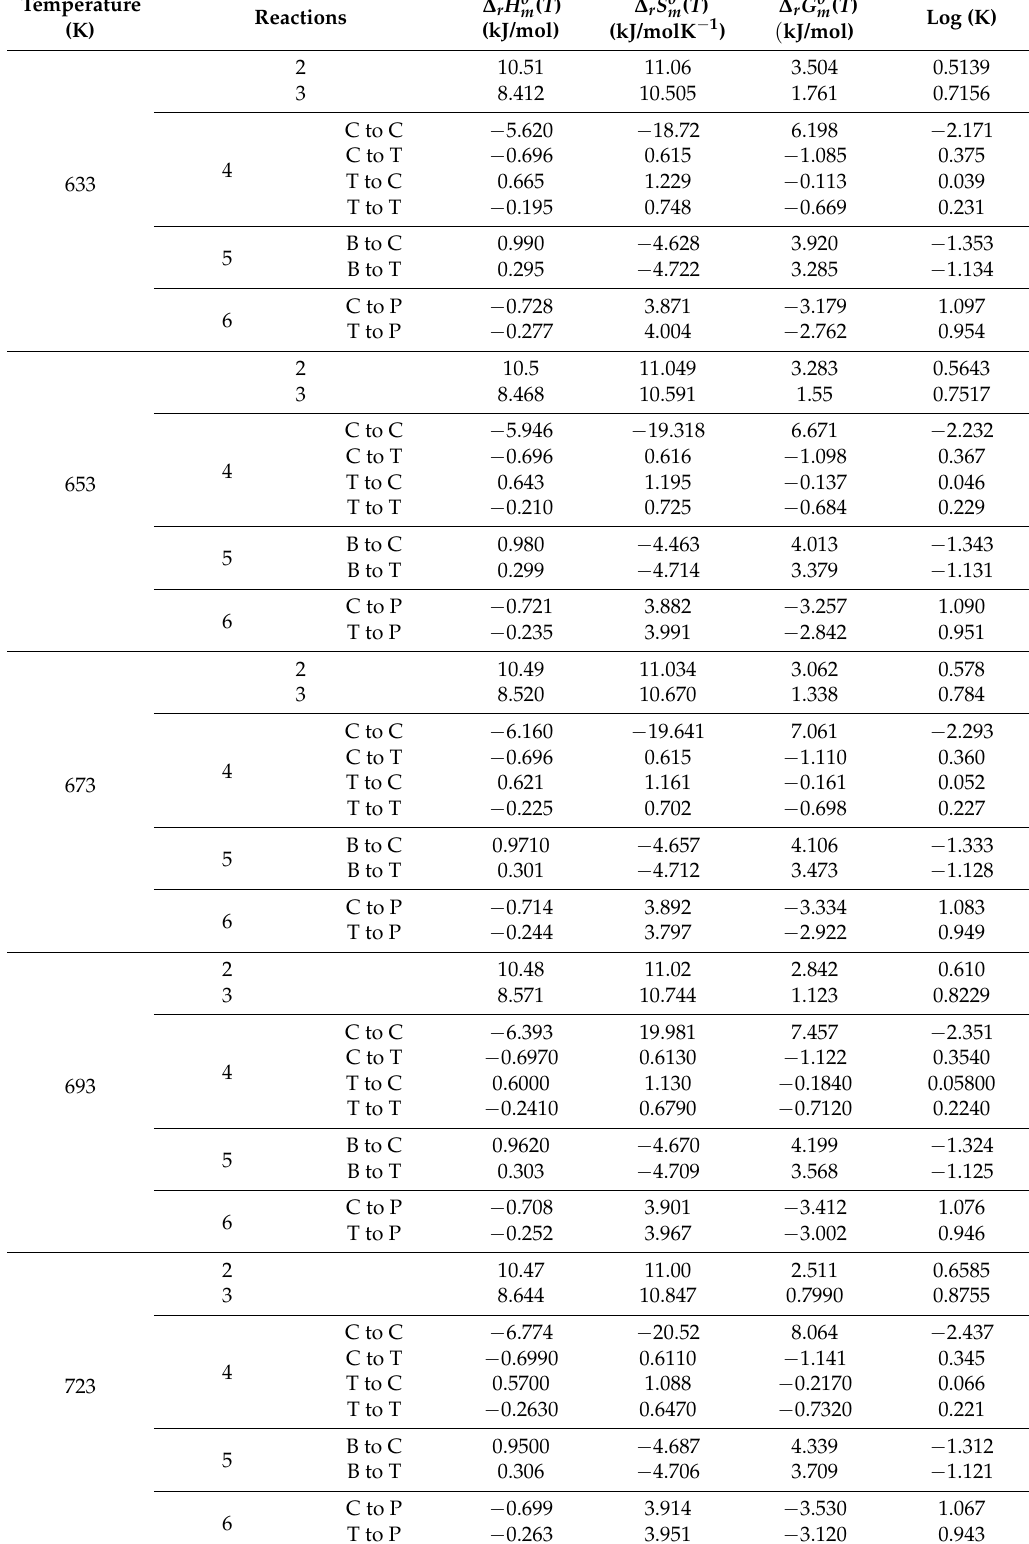
Table 3. Thermodynamic parameters of various